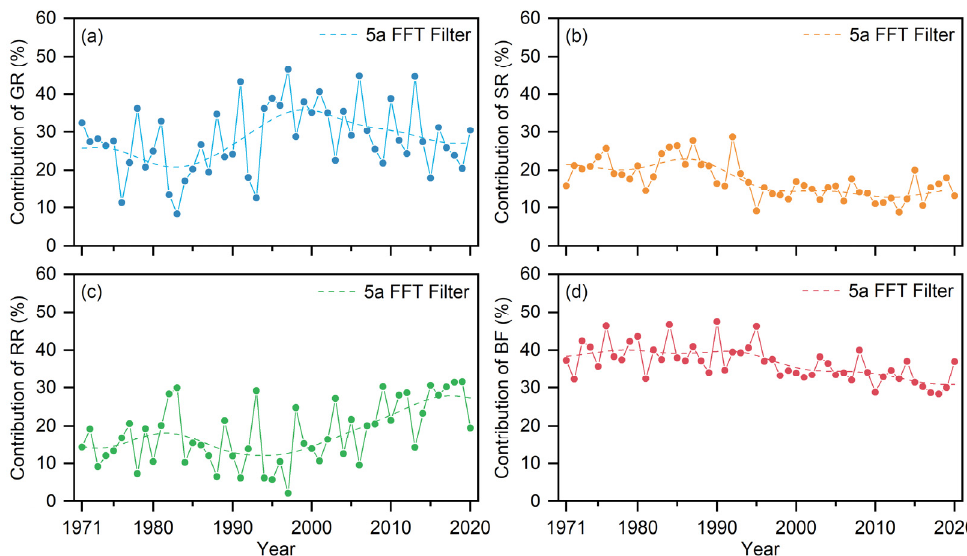
Figure 14. Interannual variation of contributions of runoff components to total runoff. ( a ) Contribution of GR; ( b ) Contribution of snow runoff; ( c ) Contribution of rainfall runoff; ( d ) Contribution of baseflow.